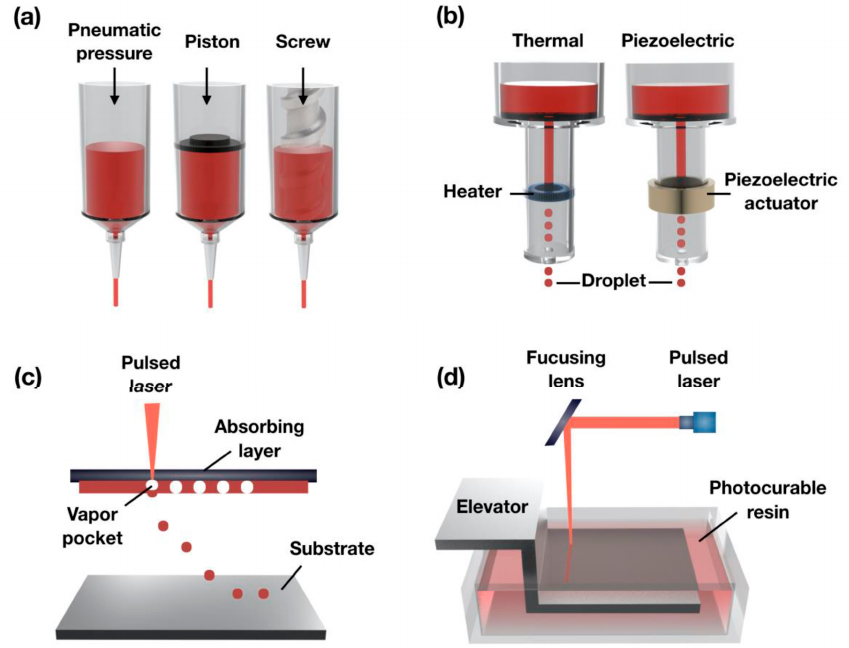
Figure 2. An overview of the commonly used scaffold-based 3D bioprinting: ( a ) extrusion-based, ( b ) inkjet-based, ( c ) laser-assisted and ( d ) vat polymerization-based bioprinting (Reprinted from Jeong et al., 2020 [119]. Copyright © 2022 MDPI under the terms of the Creative Commons Attribution 4.0 International License).